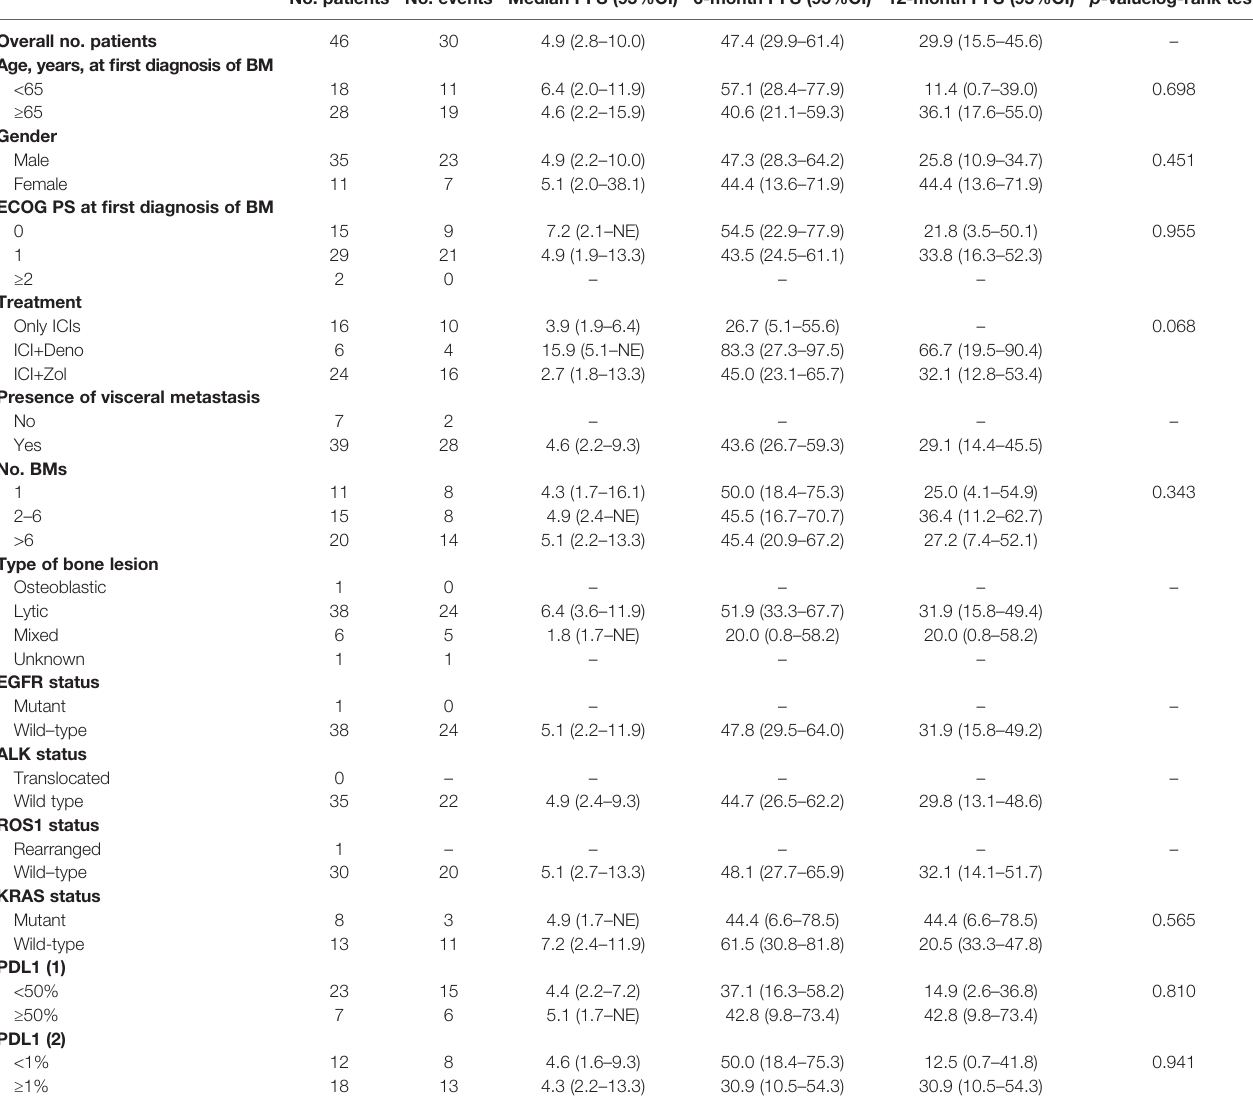
TABLE 4 | Univariable analysis of progression-free